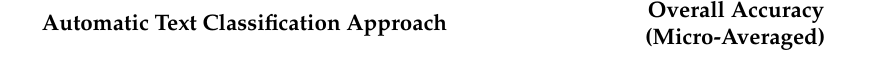
Table 7. Comparison of the highest achieved micro-averaged score of our pipeline (shown in bold), compared to other published automatic text classification results on the “ApteMod” split of the Reuters-21578 corpus. Accuracy metrics are all F1 scores, except Joachims which is the precision- recall breakeven